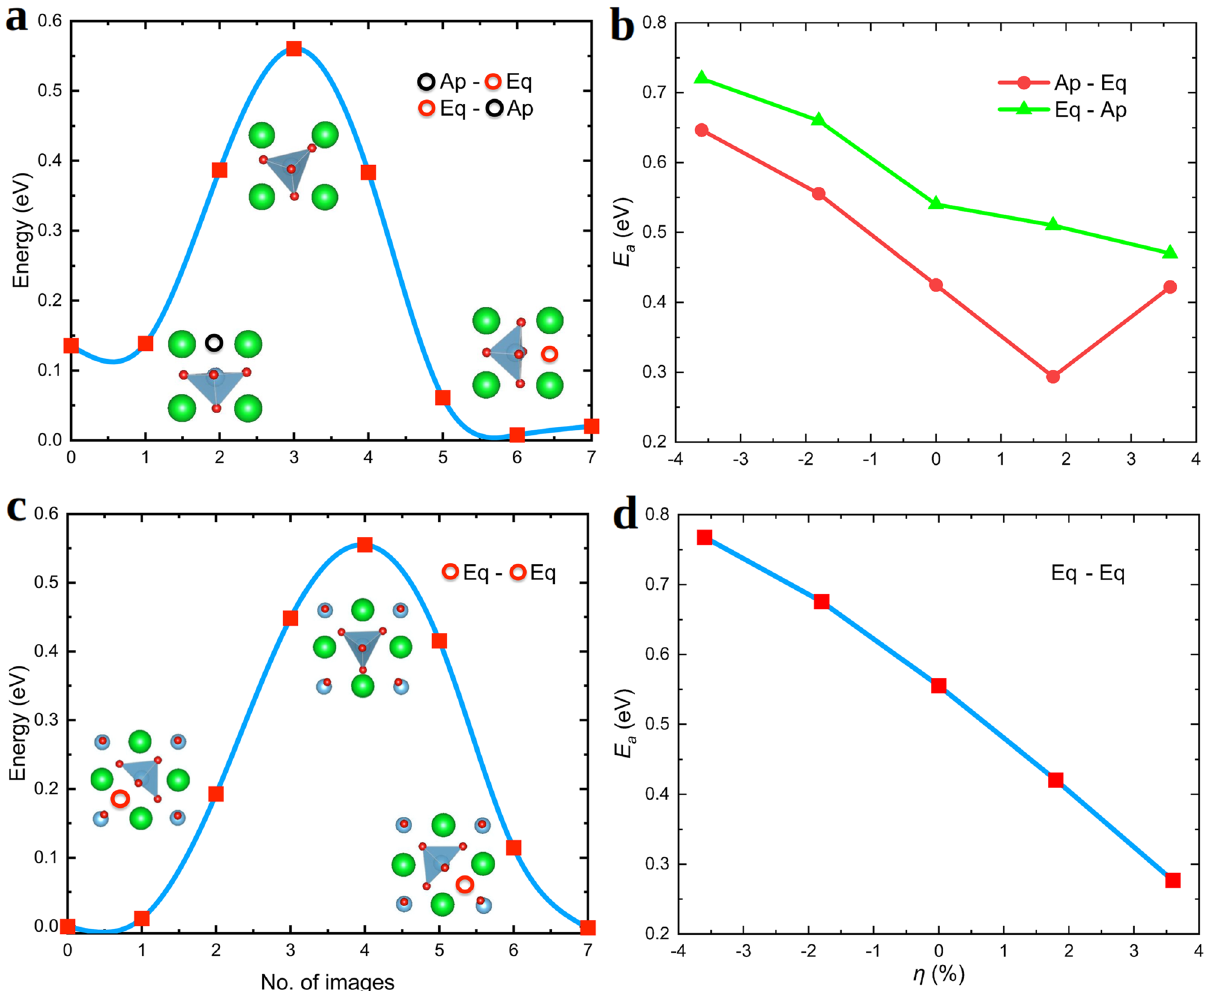
Figure 6. Energy barriers for V O diffusion calculated with the NEB method ("Nudged elastic band calculations" section) and by neglecting thermal lattice fluctuations. Representation of the analyzed oxygen vacancy diffusion paths are shown in ( a ) and ( c ) ( η = 0 case). NEB energy barrier results expressed as a function of epitaxial strain are represented in ( b ) and ( d ). Labels “Eq” and “Ap” stand out for equatorial and apical oxygen vacancies, respectively. The colouring code for atoms in ( a ) and ( c ) coincides with that indicated in Fig. 1. The solid lines are simply guides for the